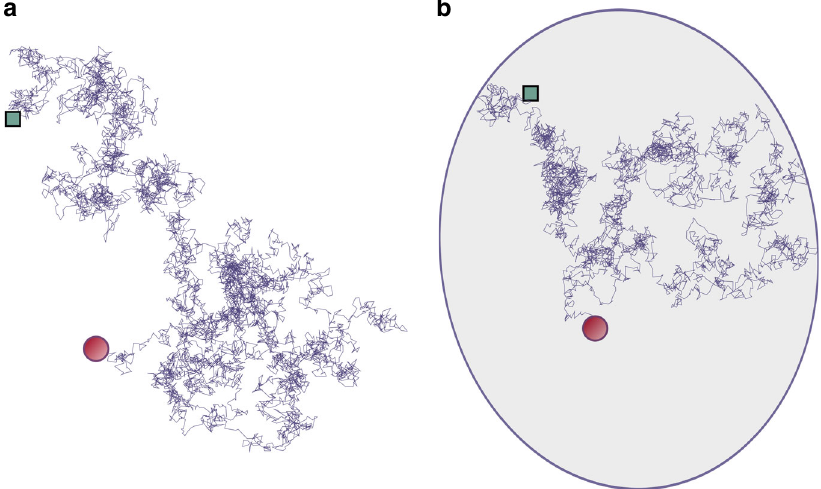
Fig. 1 First-passage problem with or without con fi nement. Two fi rst-passage problems in which a random walker starting from a given site (green square) reaches a target (red disk) at the end of a stochastic trajectory: a in free space, b in a con fi ned re fl ecting domain. Sample trajectories for fractional Brownian motion ( H ¼ 0 : 45) are